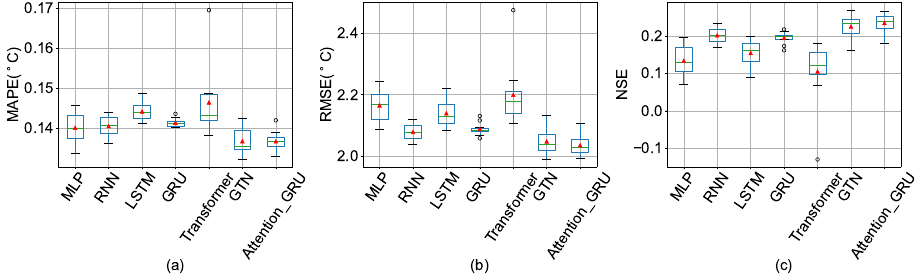
Figure A5. The box plot of ten experiment results of deep learning models under the TRMF. ( a ): The results of MAPE. ( b ): The results of RMSE. ( c ): The results of